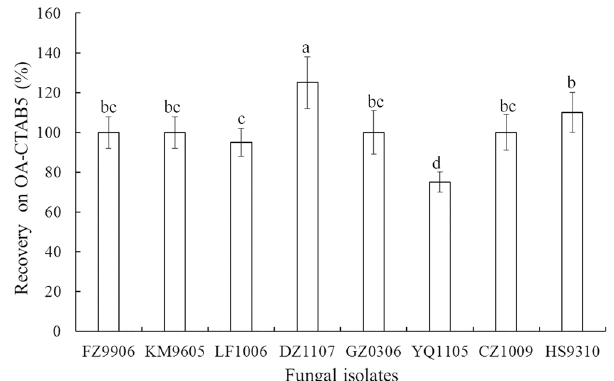
Fig 2. Intra-species variability of L . lecanii isolates on the selective medium (oatmeal CTAB 0.5 g/L). Letters above bars indicated statistical significance (LSD, P < 0.05).